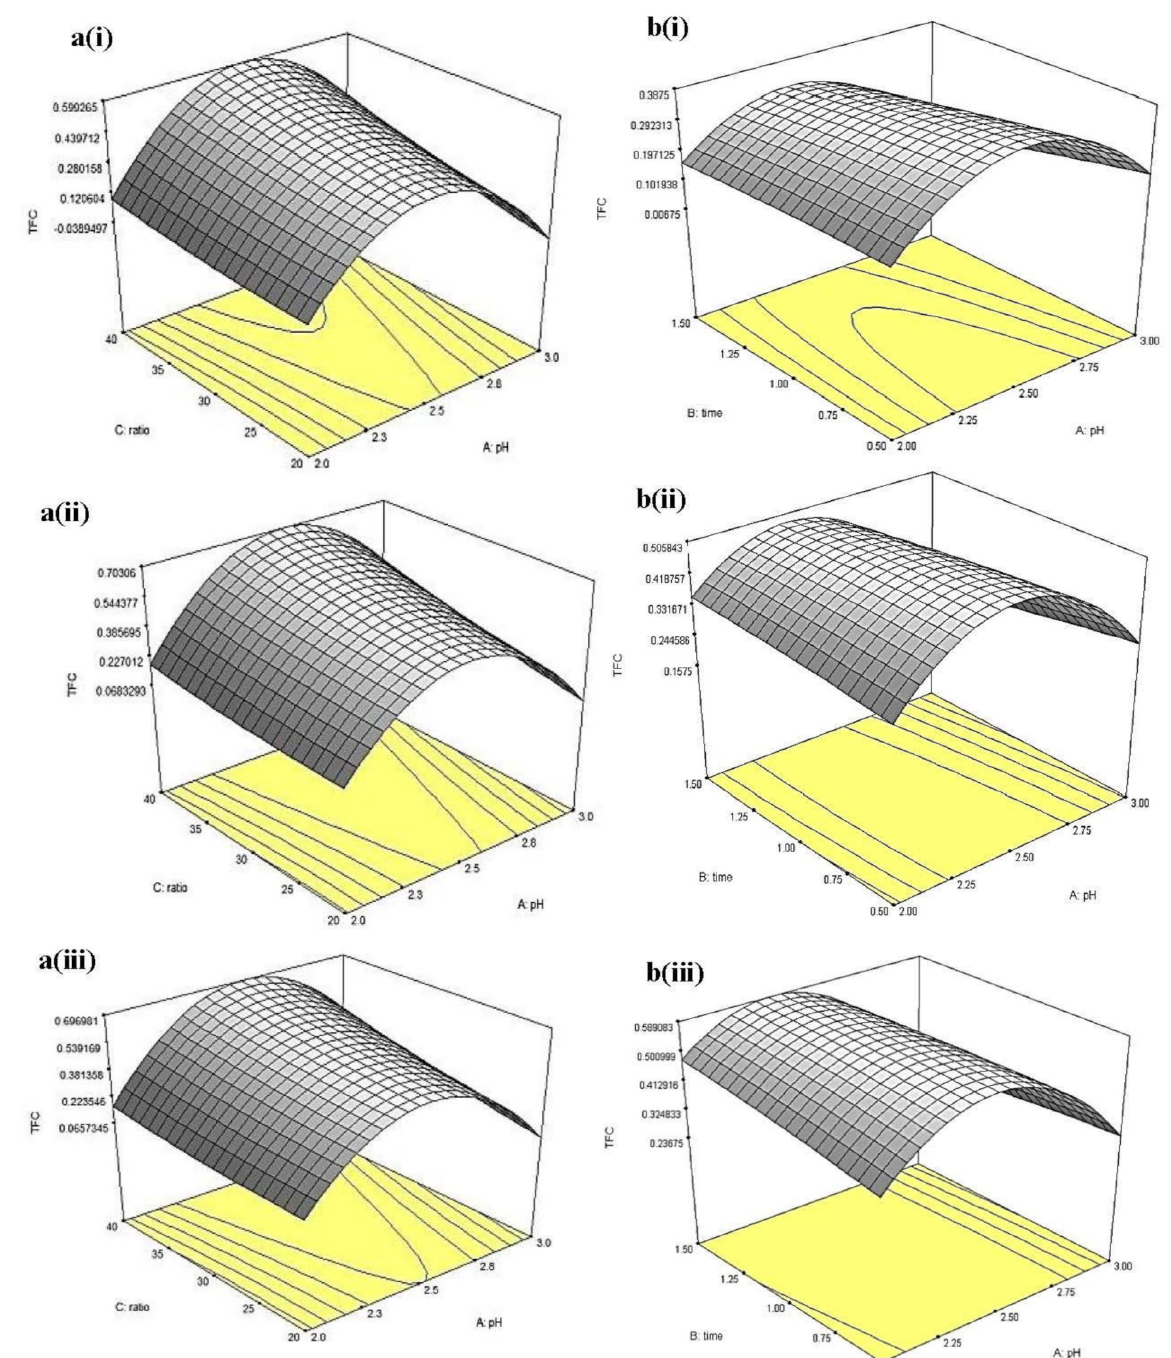
Figure 8. Three-dimensional response surfaces for TFC of ( a ) China cultivar of lotus root at (i) 0.5, (ii) 1, (iii) 1.5 h extraction time as a function of pH and solvent-to-sample ratio and ( b ) Malaysia cultivar of lotus root at (i) 20, (ii) 30, and (iii) 40 (mL/g) of solvent-to-sample ratio as a function of pH and extraction